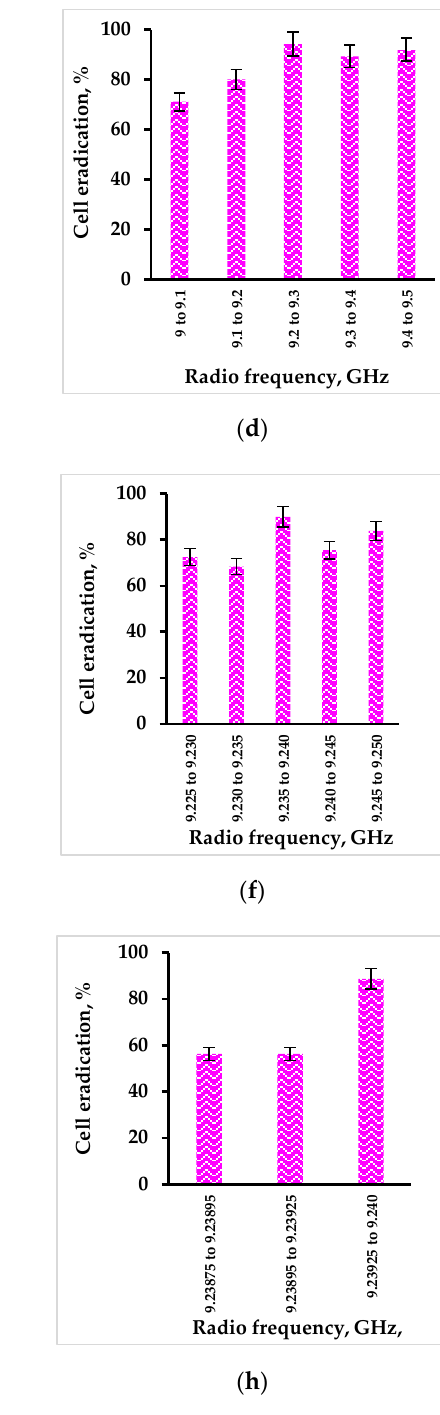
Figure 7. Effect of Rose Bengal at a concentration of 0.01 mg/mL under activation by radio waves at different frequency ranges on eradication of S. aureus at an initial cell concentration of 4.4.10 4 CFU/mL in the dark: ( a ) 1 – 20 GHz, ( b ) 9 – 13 GHz, ( c ) 9 – 10 GHz, ( d ) 9 – 9.5 GHz, ( e ) 9.2 – 9.3 GHz, ( f ) 9.225 – 9.25